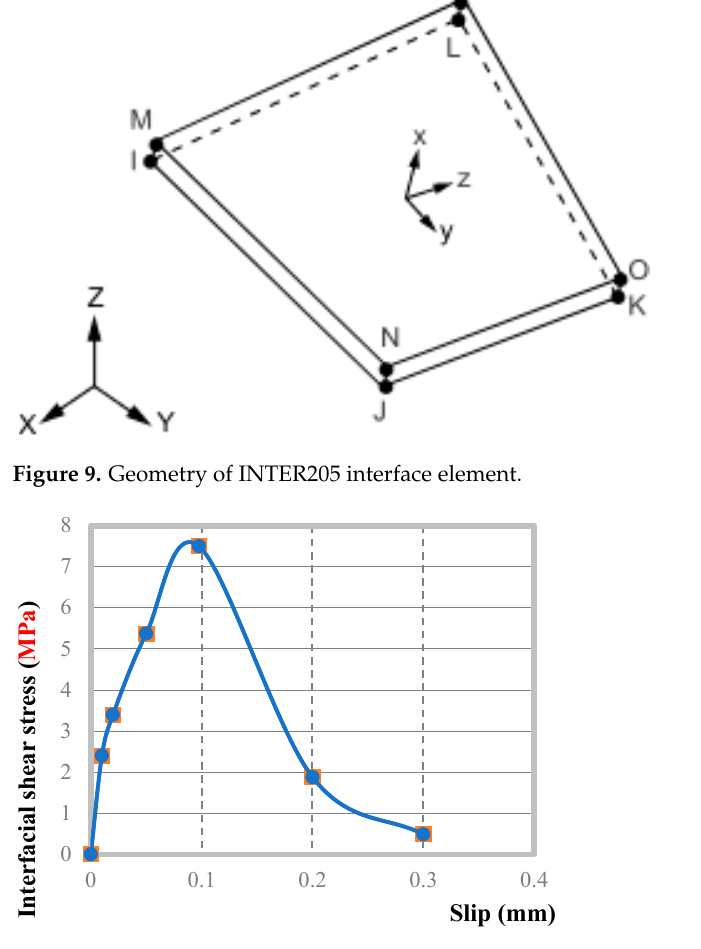
Figure 10. Relationships between the local shear stress and the associated slip.